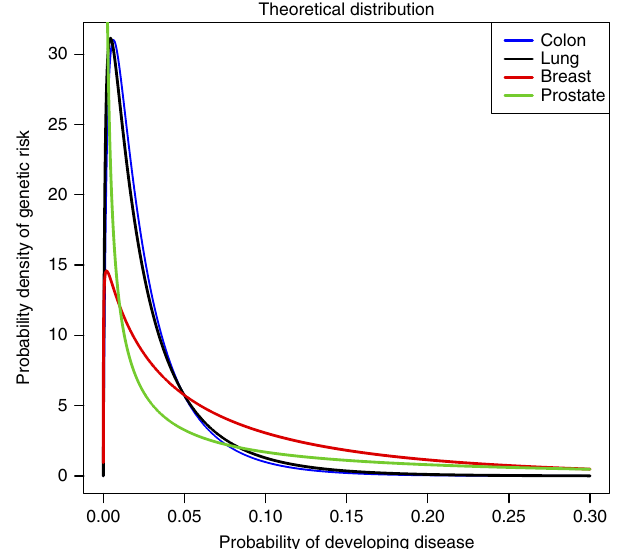
Fig. 1 Genetic risk distribution for four common cancers. The distribution of risk due to genetic differences is displayed for four common cancers, using heritability and prevalence data from Nordic twin registries